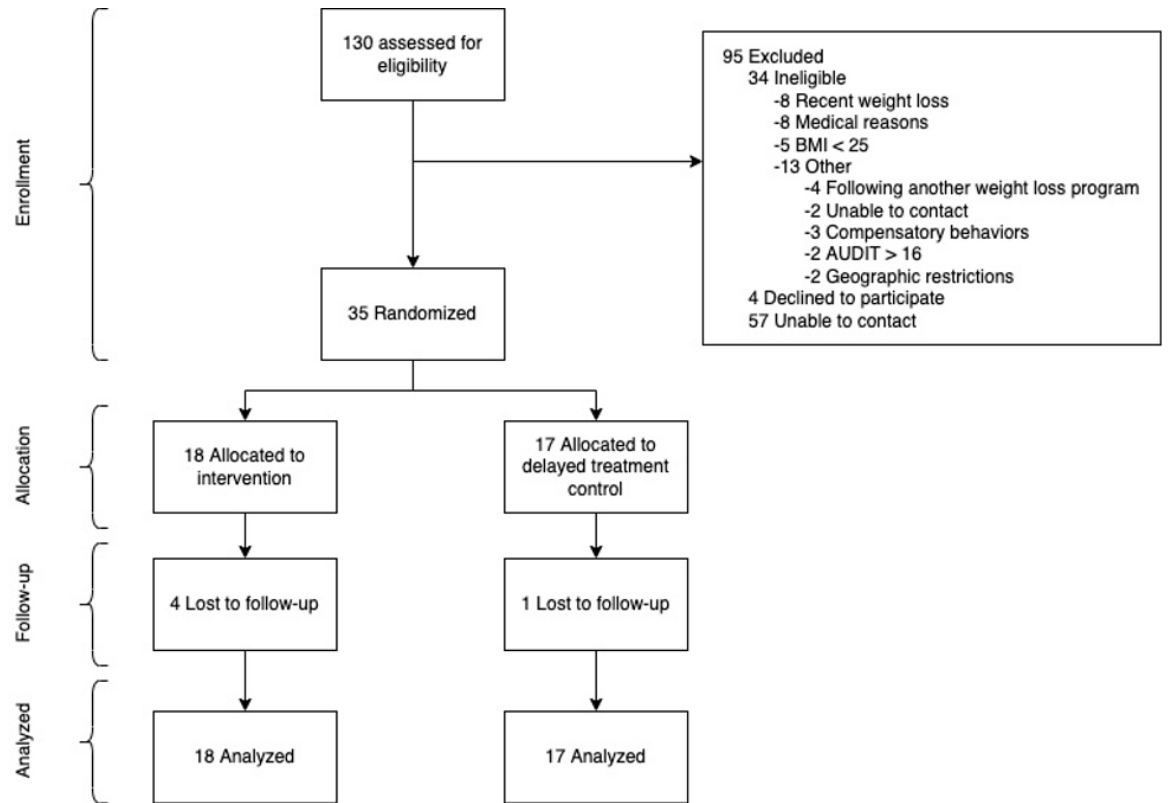
Fig. 3. CONSORT flow